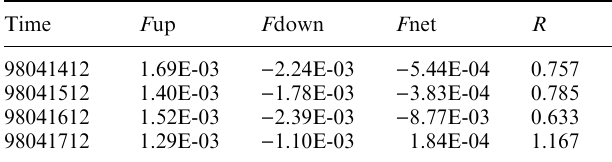
Table 1. Domain-averaged upward ( F up), downward ( F down) and net ( F net) fluxes (in kg m ) 2 s ) 1 ) and the ratio of the domain- averaged upward and downward fluxes ( R = | F up/ F down|) across the 2 PVU surface for 14, 15, 16 and 17 April 1998, 12 GMT